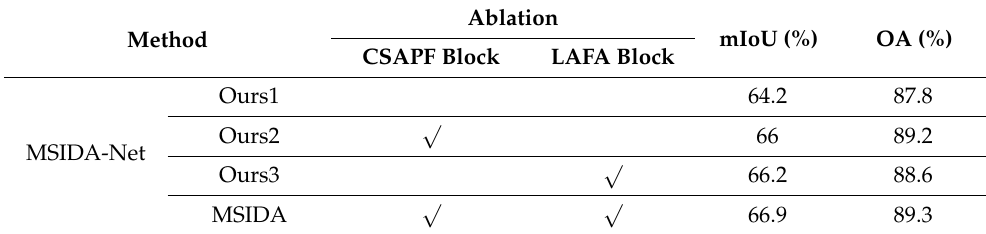
Table 5. The ablation results of the coordinate system features.